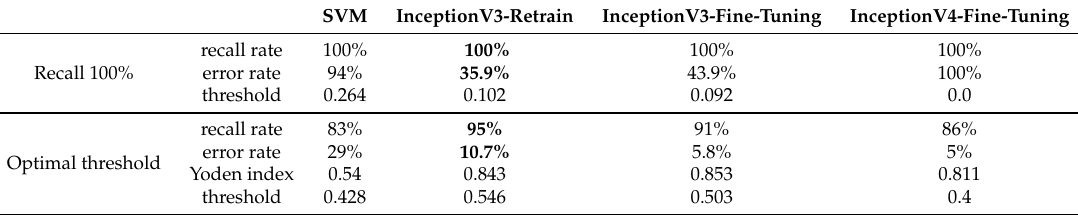
Table 2. Classification algorithm data.